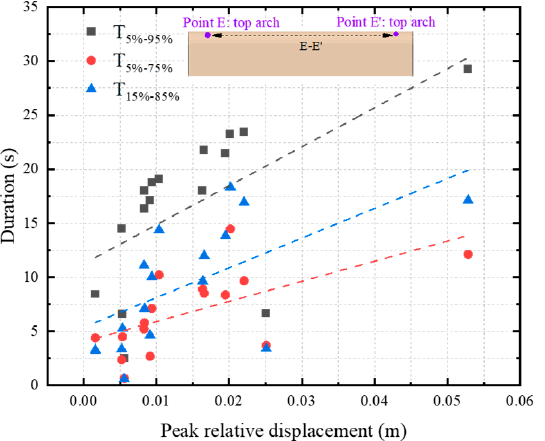
Figure 7. The peak longitudinal displacement of the concrete lining under different fixed threshold values of EVD.